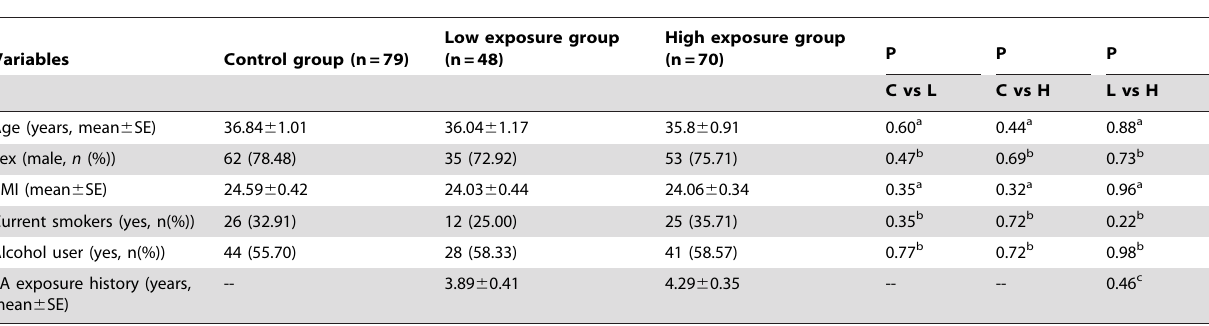
Table 2. Demographic data of FA-exposed workers and controls.